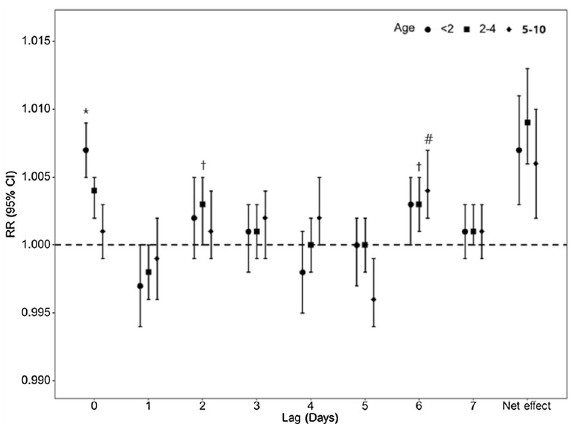
Figure 3. Relative risks of PM 10 for acute otitis media according to lag times in three age groups. Lag 0–7 means days prior to acute otitis media. Three marks (*, †, #) indicate significant increases.